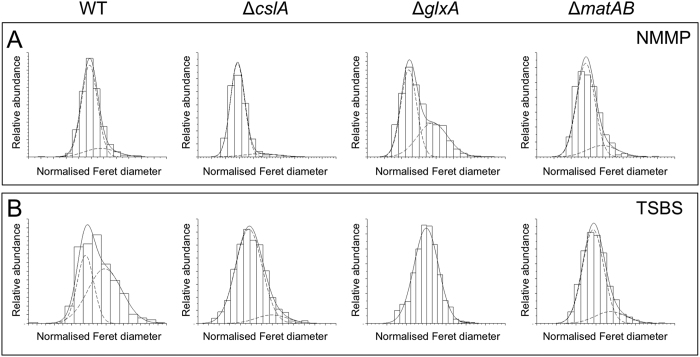
Quantitative analysis of particle size heterogeneity in the absence of cslA, glxA and matAB.Normalized particle size distributions of the S. lividans wild-type strain, the cslA deletion strain, the glxA deletion strain and the matAB deletion strain in NMMP (A) and TSBS (B) after 12 h of growth. The x-axis represents the normalized Feret diameter, while the y-axis represents the relative abundance. The two dashed lines in each plot represent the two normally distributed populations of particles fitted to the actual measured distribution (solid line). Size heterogeneity is strongly diminished in the absence of the cslA, glxA and matAB genes in TSBS medium.